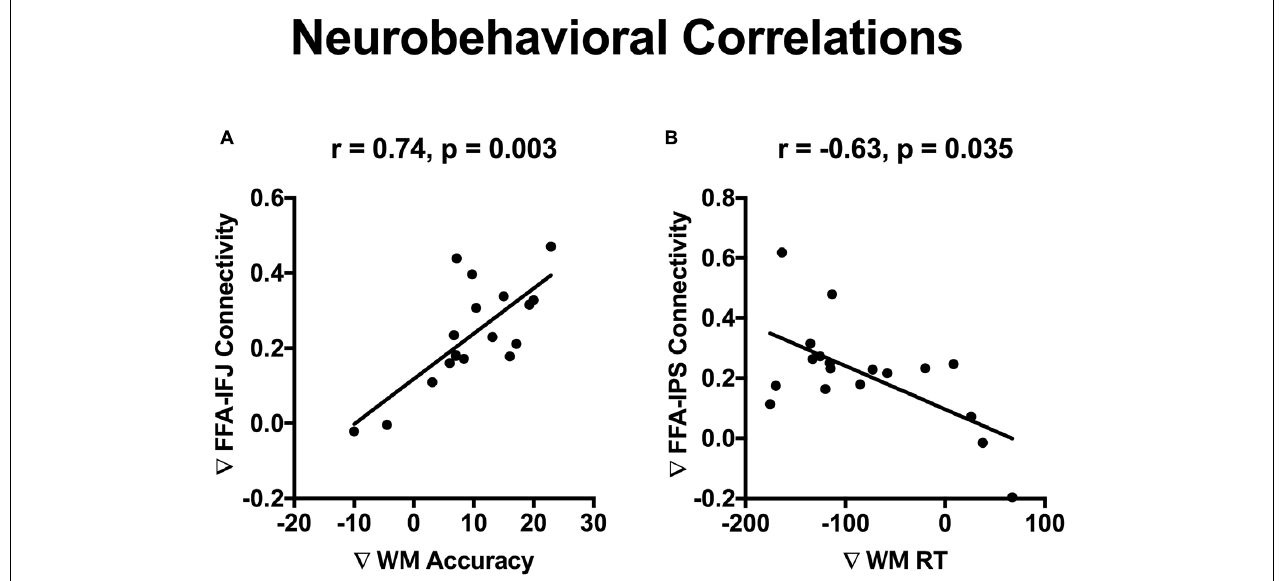
FIGURE 5 | Neurobehavioral correlations. Significant correlations were revealed between WM accuracy increase and connectivity differences of FFA-IFJ ( r = 0.74; p = 0.003; A ), and between WM RT decrease and connectivity difference of FFA-IPS ( r = –0.63; p = 0.035; B ), after Bonferroni correction for multiple comparisons.